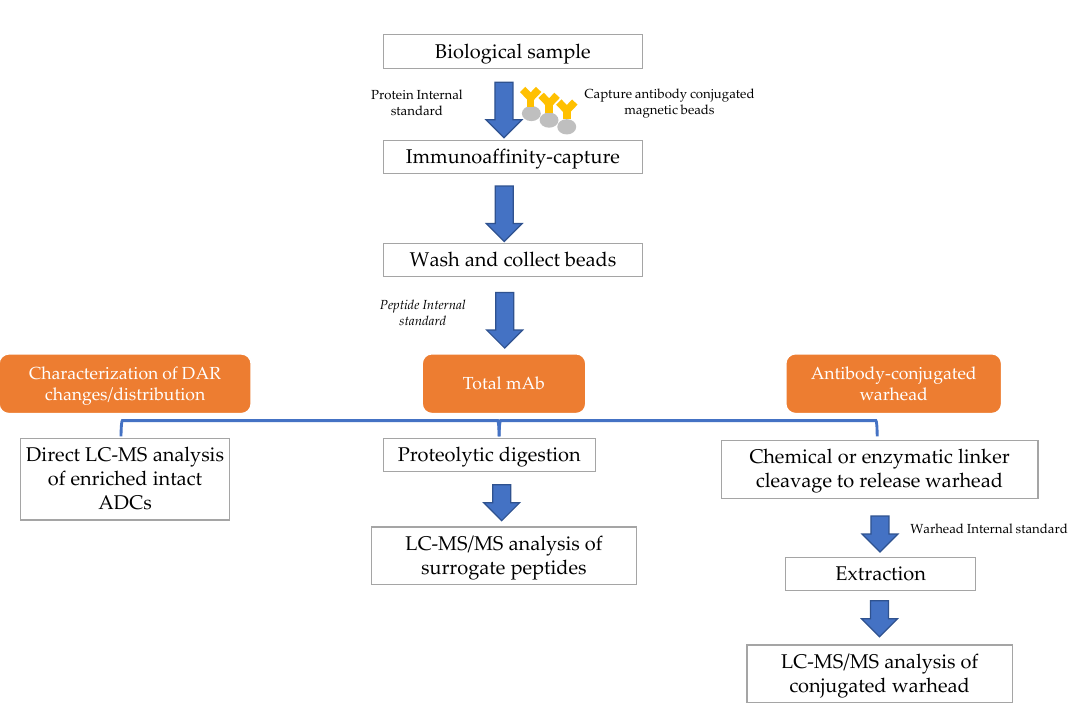
Figure 2. A typical workflow for bioanalysis of antibody-drug conjugates (ADCs) using hybrid LBA-LC-MS (ligand binding assay - liquid chromatography coupled with mass